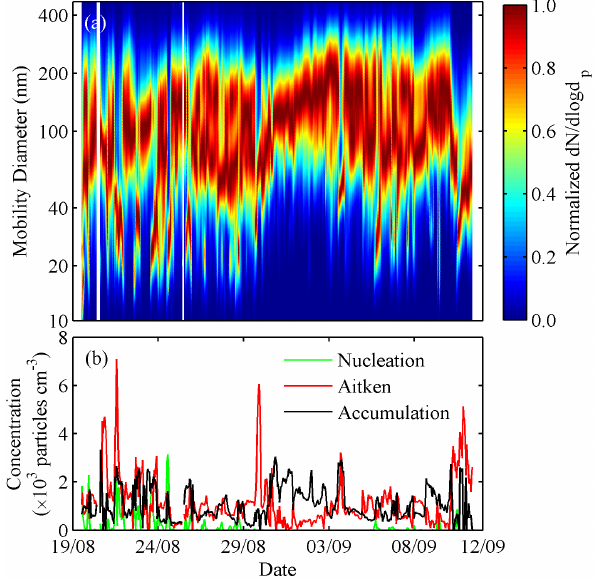
Fig. 2. Evolution of normalised, hourly averaged size distributions of particles having dry mobility diameters from 10 to 487nm (a) , and temporal variation of the respective number concentration of particles residing in the nucleation, Aitken and accumulation modes (b) throughout the whole period of the Aegean-Game field campaign.